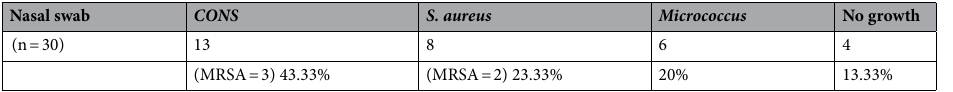
Table 5. Nasal carriage of microorganism of health care workers. Organism isolated from anteriornares of health care workers. The organism which was isolated is CoNS (13/30), S.aureus (8/30), and Micrococcus (6/30).